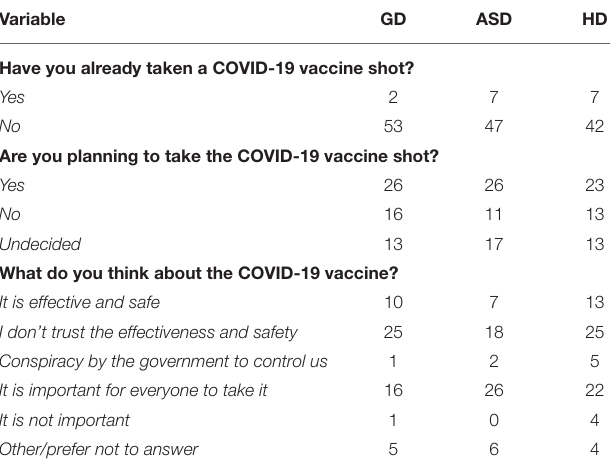
TABLE 4 | Perception and acceptance of COVID-19 vaccination. Variable GD ASD